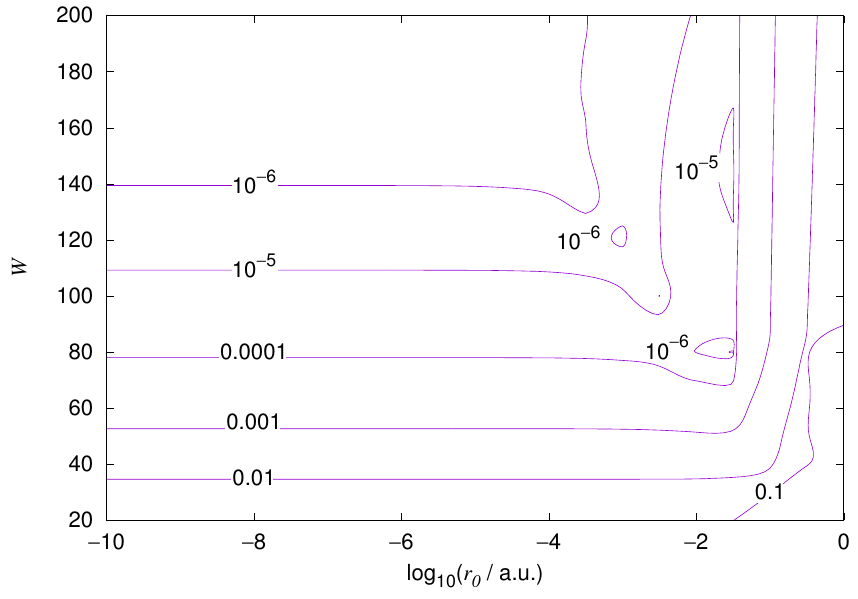
Figure 2. Relative error of the wavefunction value at the core radius for the hydrogen 1s orbital. Notations as in Figure